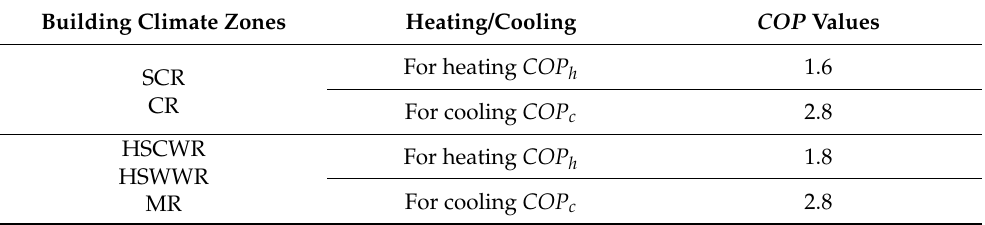
Table 2. COP of a split air conditioner used in a residential building for heating and cooling, which were provided according to standards